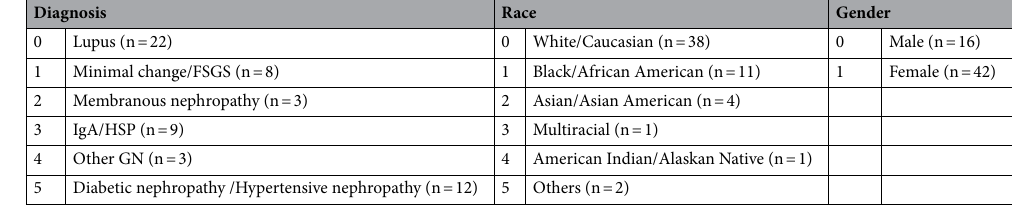
Table 1. Baseline characteristics of the